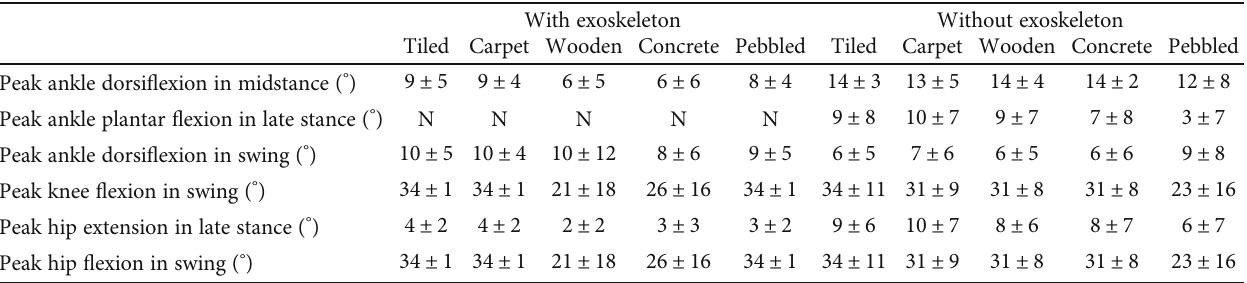
Table 2: Gait parameters with/without exoskeleton at fi ve kinds of pavements. With exoskeleton Without exoskeleton Tiled Carpet Wooden Concrete Pebbled